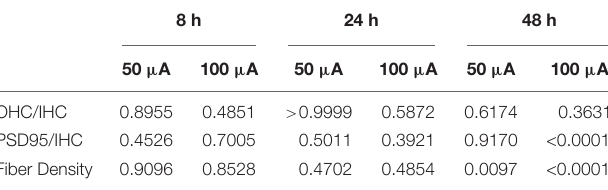
TABLE 1 | P value of OHC/IHC ratio, fiber density and PSD95/IHC ratio of the 50 and 100 µ A group compared with Non-ES